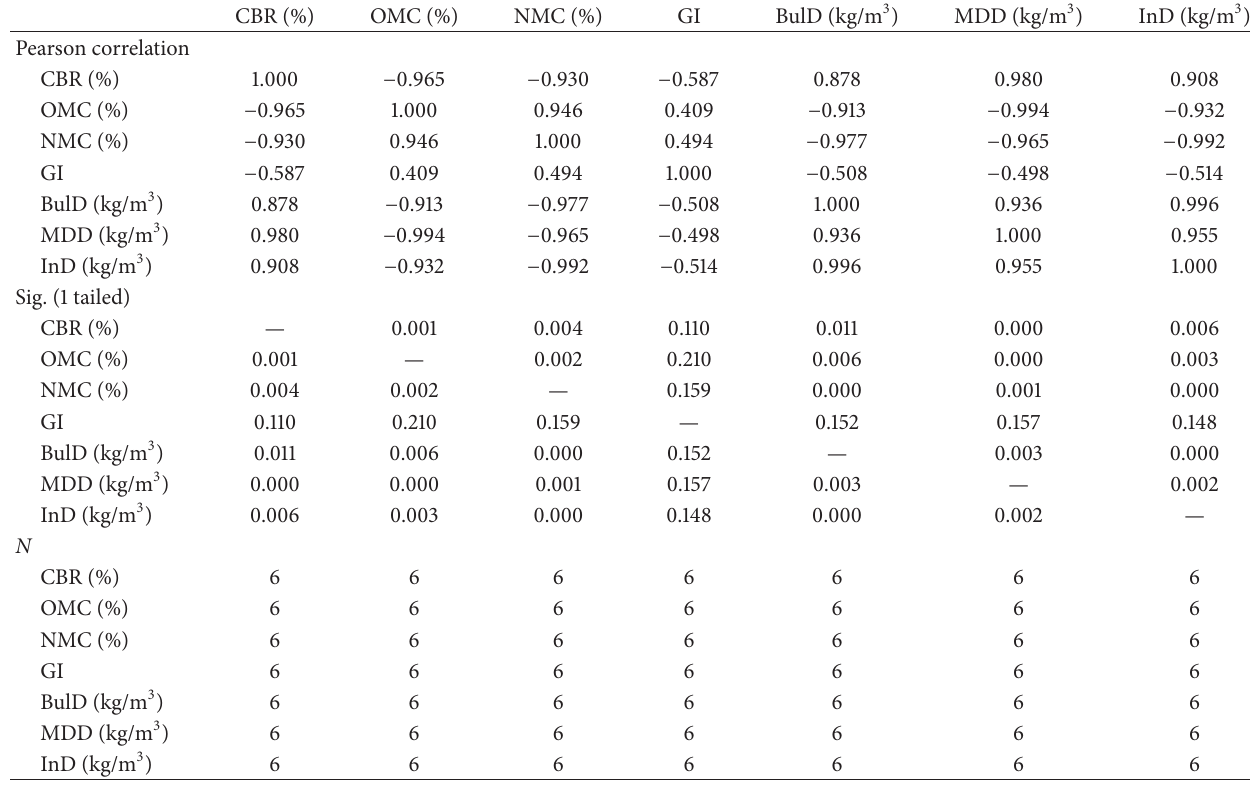
Table 7: Correlations (CBR).